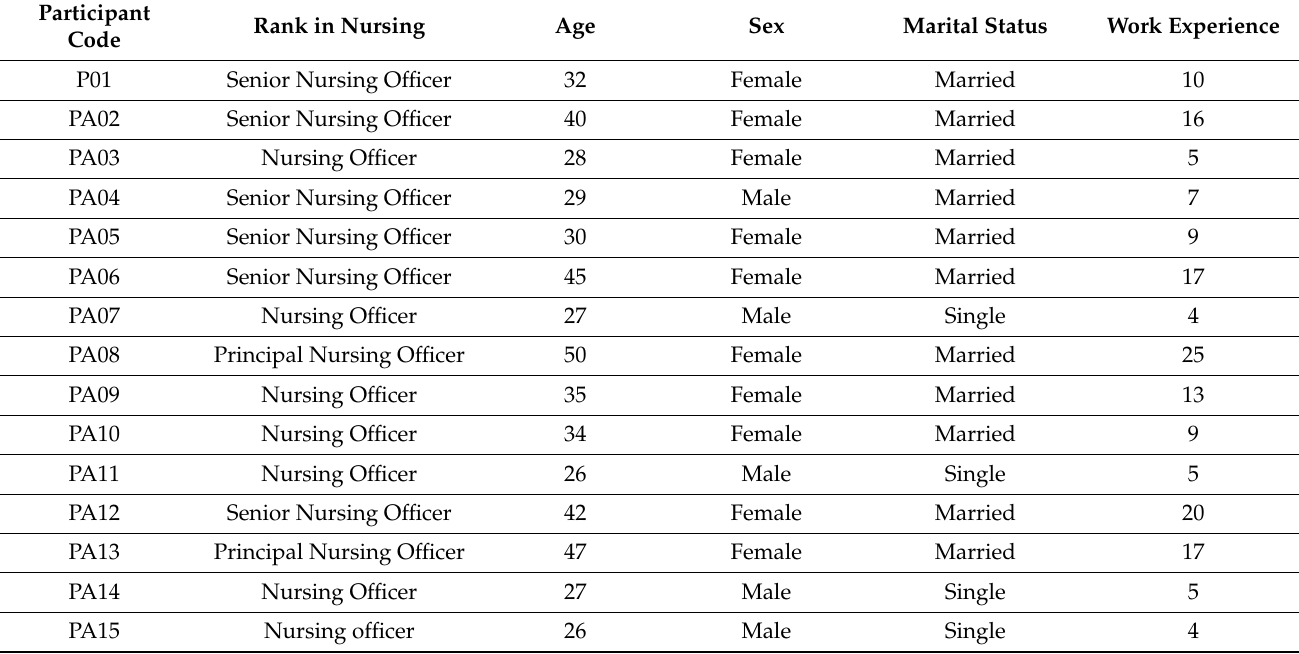
Table 1. Profile of